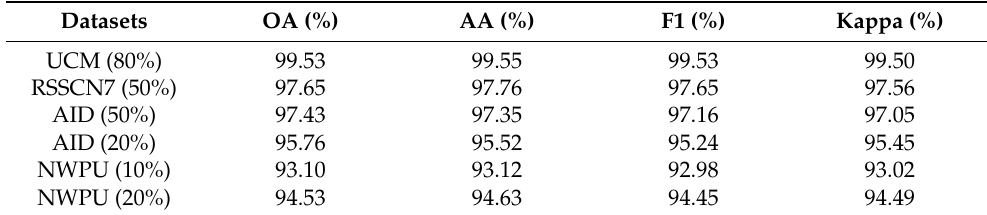
Table 1. The OA, AA, F1 and Kappa results of the proposed LCNN-HWCF model on four